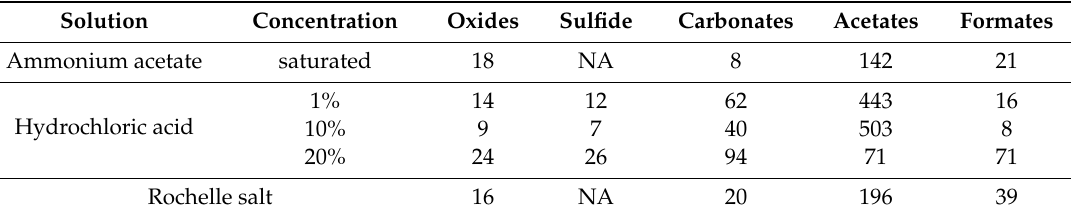
Table 7. Ratios of corrosion products and bare metal dissolution